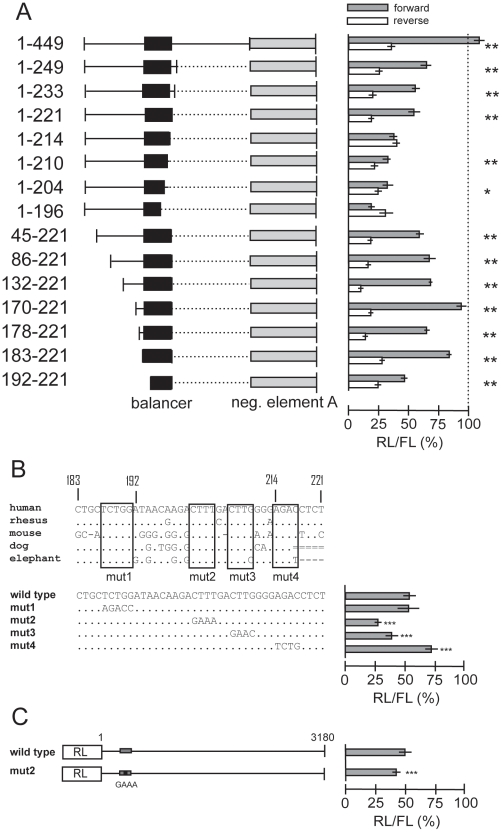
Mapping of the balancer element counteracting the negative elements.(A) The indicated 5′ sequences of the HNF4A 3′UTR were cloned upstream of negative element A (850–1207, light grey box). The identified balancer is marked by a black box. Luciferase assays were performed in INS-1 cells as described for Fig. 2. Grey and white bars represent results obtained with the constructs containing the 5′ sequences in front of negative element A in forward (5′-3′) and reverse orientation (3′-5′), respectively. The results of luciferase assays were derived and evaluated as in Fig. 2. p-values of<0.01 and of <0.001, determined between the forward and reverse orientation of each construct, are indicated by * or **, respectively. (B) The balancer sequence identified in the human 3′UTR of HNF4A was aligned to the corresponding sequence of other mammals using the UCSC Genome Browser (hg18, multiz alignments of 44 vertebrates). The four regions conserved are boxed. Below, the wild type balancer sequence and the four mutants tested in front of the negative element A (850–1207) are given. Their performance in the luciferase assay in INS-1 cells is summarized from at least three independent preparation of each construct. p-values of<10−5 (***) are calculated in comparison to the wild type sequence using an independent-samples t test. (C) The long (1–3180) 3′UTR linked downstream of the Renilla luciferase (RL) and a corresponding construct containing mut2 given in panel B were assayed in INS-1 cells. The balancer (grey box) and mut2 (black box) are not drawn to scale. Eight and ten independent plasmid preparations were used for the wild type and mut2 construct, respectively. p-values of<10−5 (***) are calculated in comparison to the wild type sequence using an independent-samples t test.